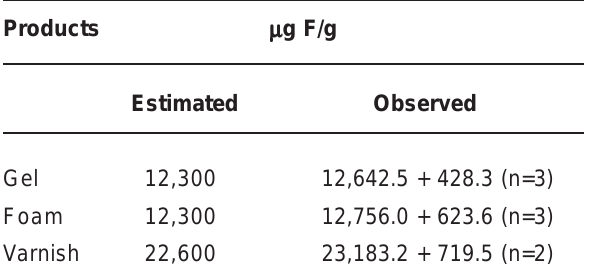
TABLE 2 - Means + standard deviations of fluoride concentrations ( µ g F/g) in fluoridated gel, foam and varnish